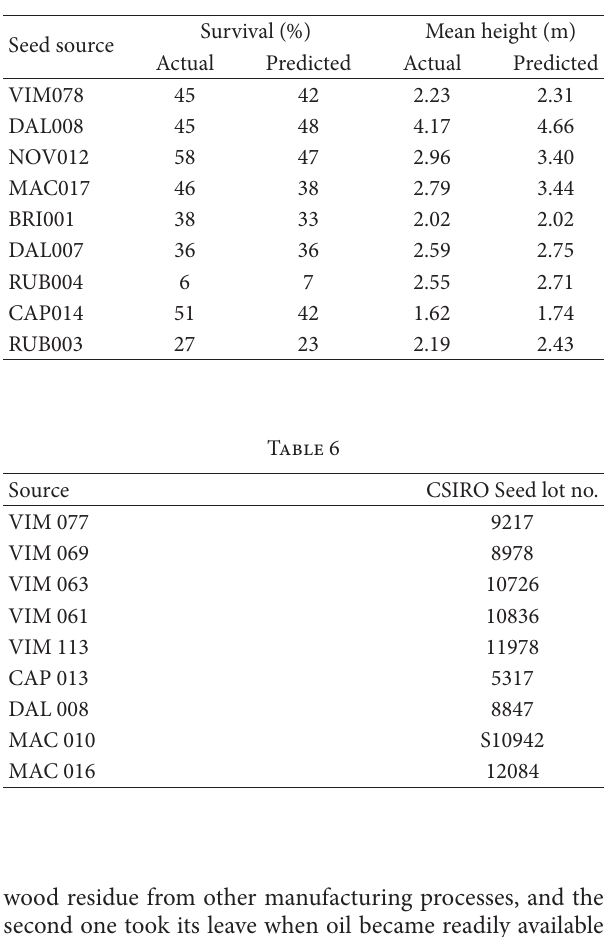
T 3: Comparison of actual versus predicted development—age 6 months.